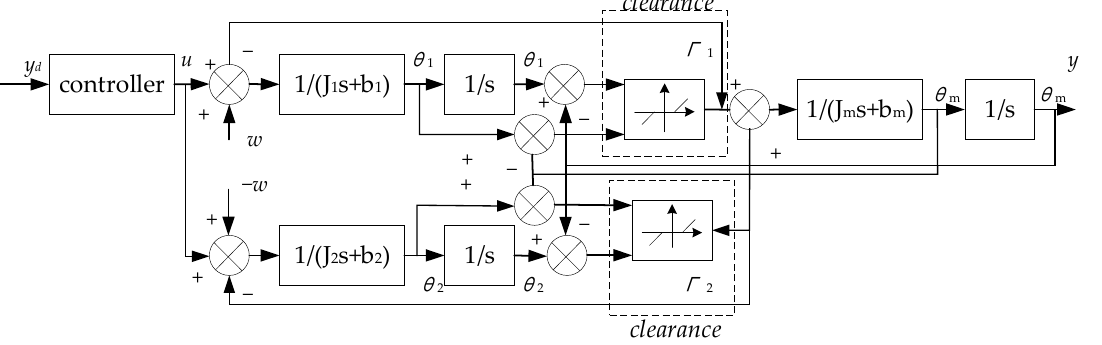
Figure 11. Block diagram of a dual-motor driving servo system.